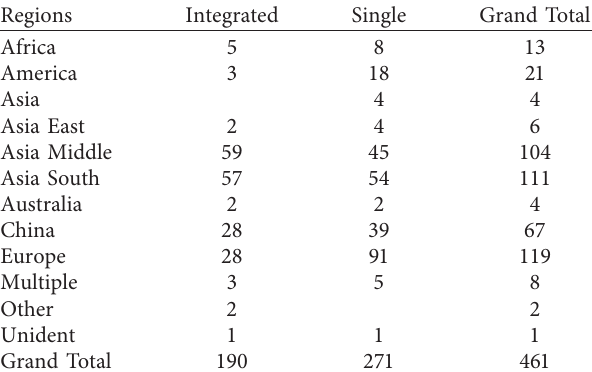
Table 2: Crosstabulation by type of method and region.